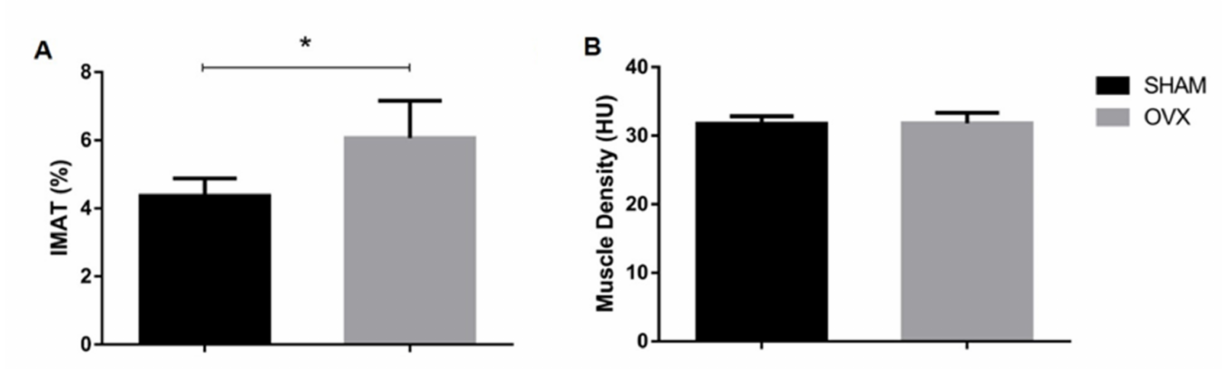
Figure 2. ( A ) IMAT% was significantly higher in OVX rats than in SHAM rats (* p < 0.05). ( B ) No significance was detected for MD between the two